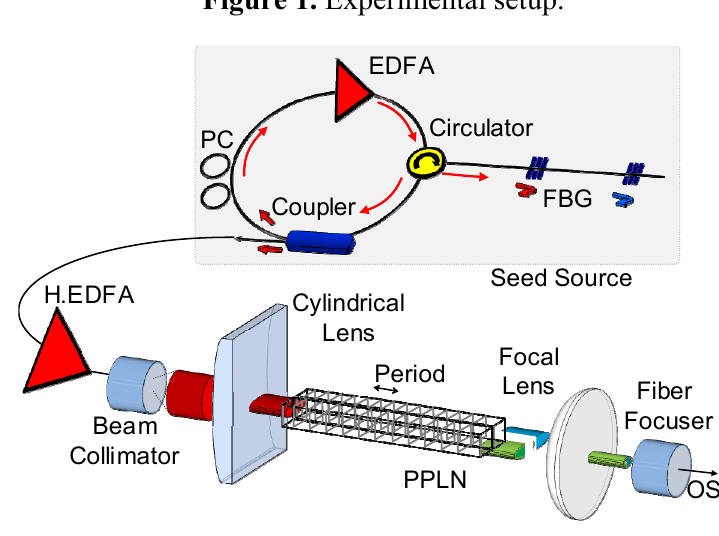
Figure 1. Experimental setup.